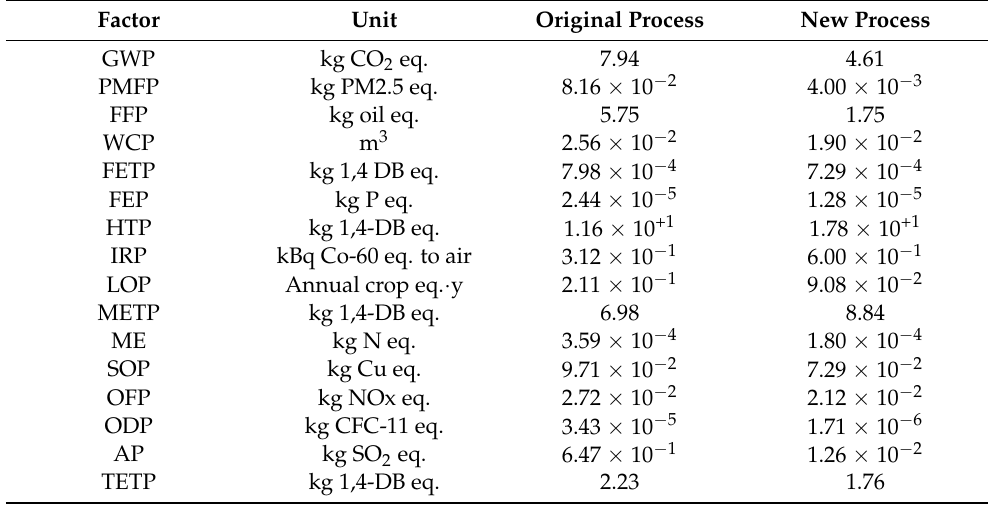
Table 5. Comparison of the life cycle impact indicators of the silver separation processes.